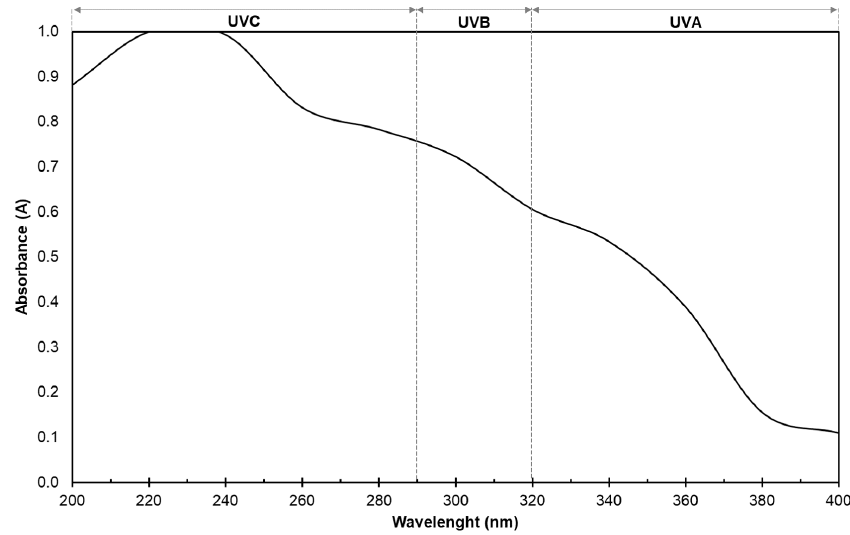
Figure 6. Ultraviolet absorption spectrum of the starch-PEJP film.